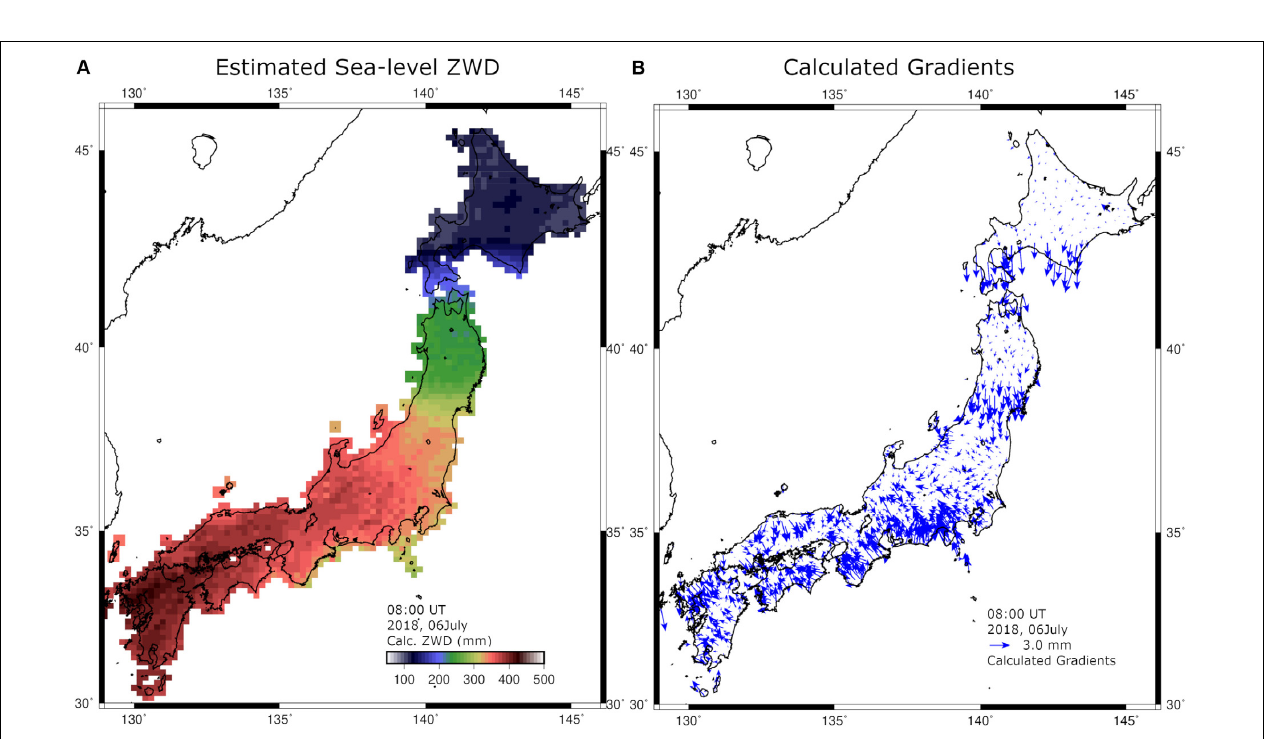
FIGURE 5 | (A) Output of the inversion, that is, sea-level ZWD at grid points at 08 UT (17 LT) on July 6, 2018. (B) shows the atmospheric gradient vectors calculated at GEONET stations using Eq. (5) and the estimated ZWD shown in (A) . They are consistent with the observed gradients shown in Figure 4A .